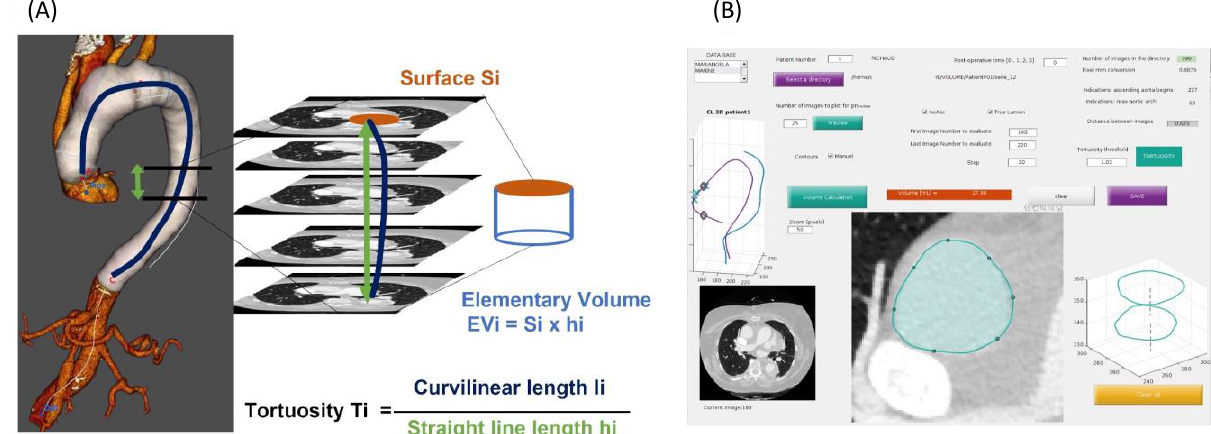
Figure 2. Method for the volume measurement with the TAV method. ( A ): Diagram showing the volume calculation method with MATLAB. ( B) : The interface used for the volume measurement.